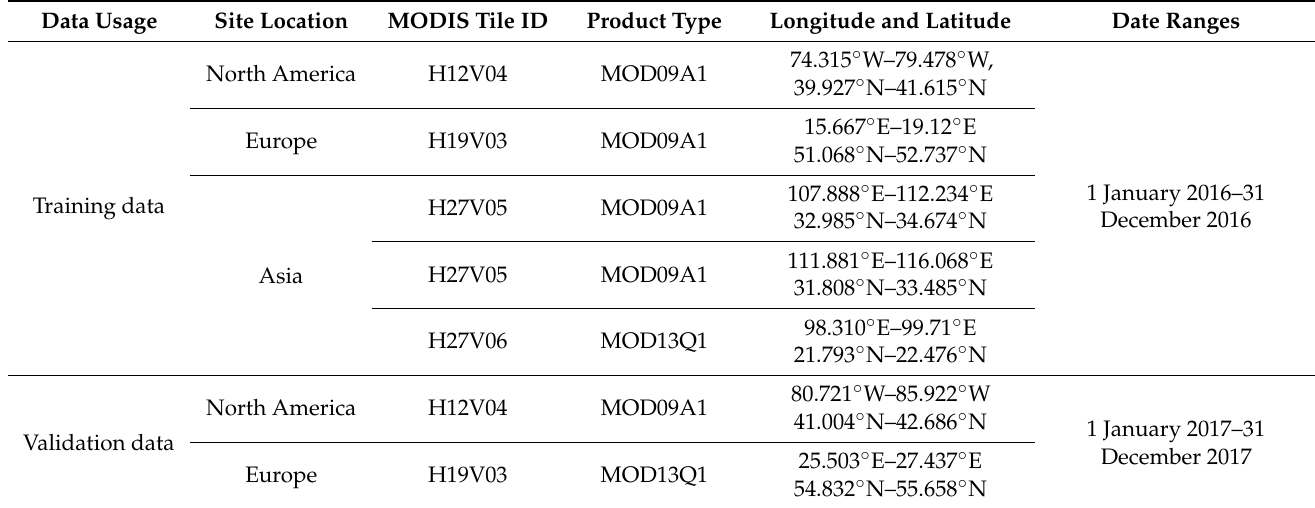
Figure 1. The spatial distribution of the study areas and the study data. Table 1. MODIS product (MOD09A1 and MOD13Q1) instances in this study.